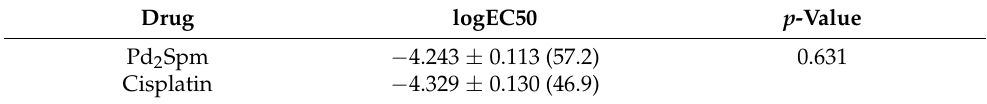
Table 2. Migration of MDA-MB-231 cells (logEC50 values of Pd 2 Spm and cisplatin).